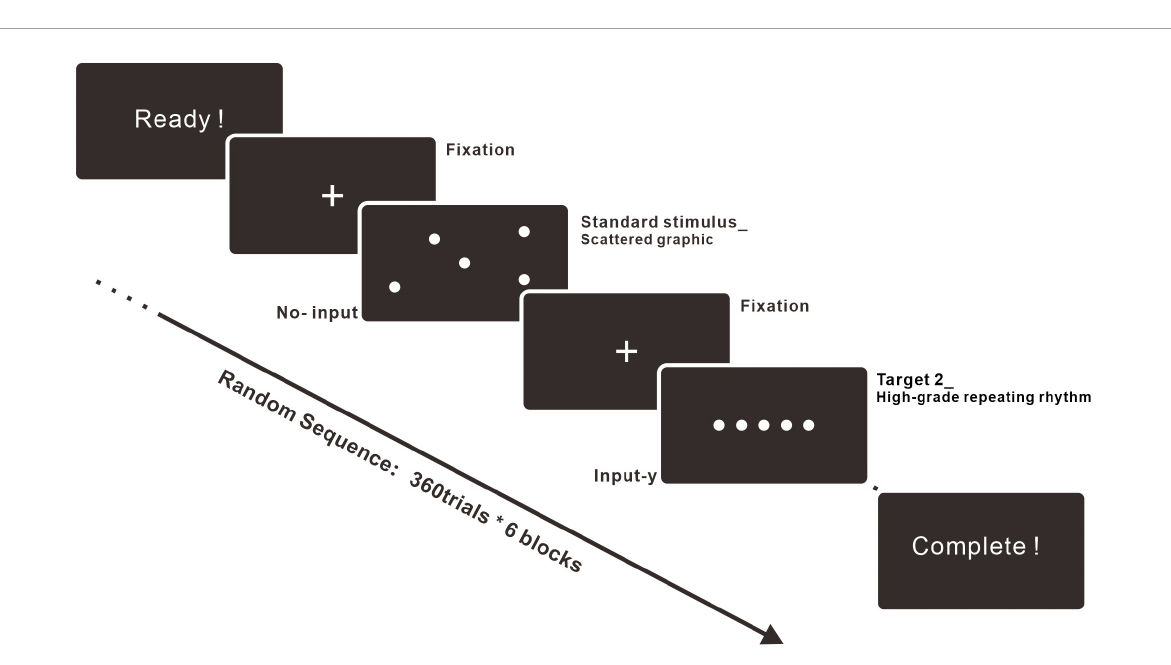
FIGURE3 Experimental procedure. The experiment included six blocks. Each block consisted of 360 trials, and every trial was composed of fixation (600 ms), stimulus (1500 ms), and ISI (500 ms). The stimulus could be the standard stimulus (70%), Target 1 (15%), or Target 2 (15%). The trials were run in random